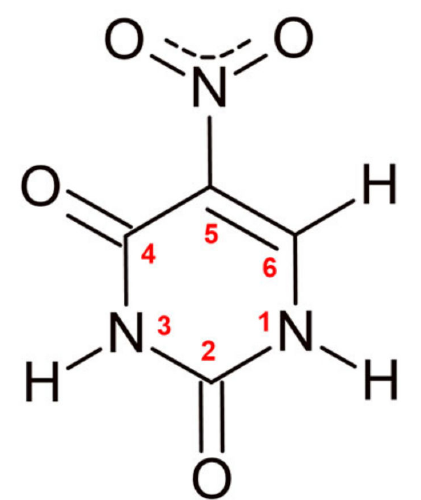
Figure 1. Schematic molecular structure of 5NU with numbering